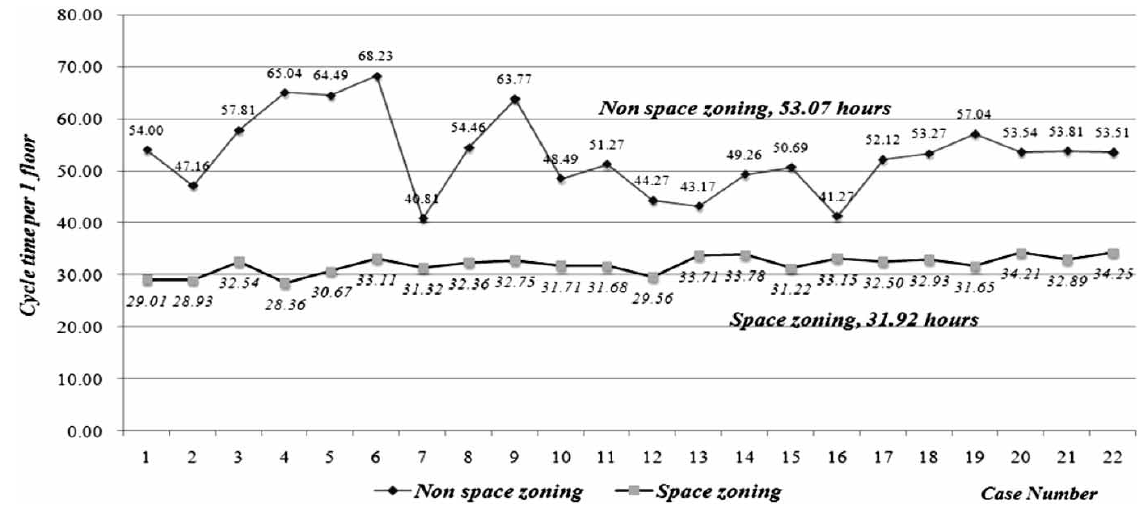
Fig. 7. Comparison between nonspace zoning and space